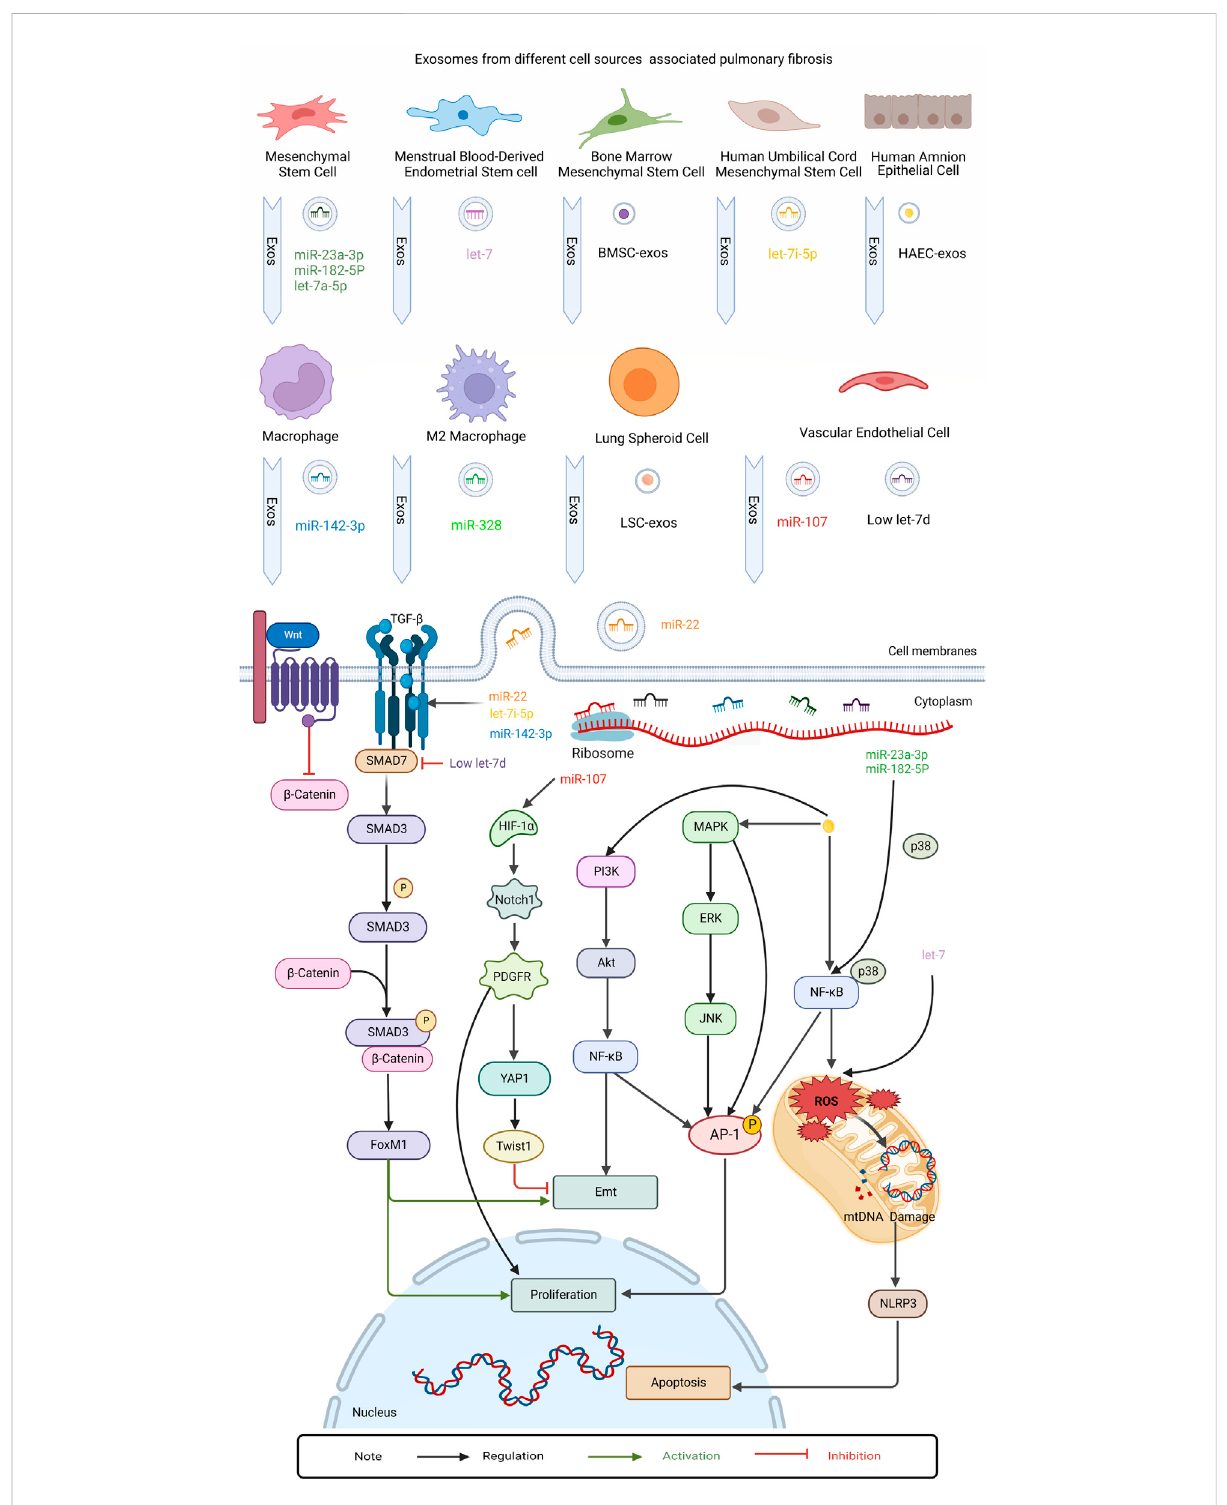
FIGURE 4 This fi gure summarizes the role of regulatory exosomes in PF. Mechanism investigation revealed that exosomes secreted by different kinds of cells, eg: human amnion epithelial cell (HAEC), Menstrual Blood-Derived Endometrial Stem Cell (MenSC), Mesenchymal stem cells (MSC), Human umbilical cord mesenchymal stem cell (HUCMSC), Bone marrow mesenchymal stem cell (BMSC), Pluripotent stem cell (iPSC), Lung spheroid cell(LSC), Vascular endothelial cell (EnC), Macrophage, M2 macrophages. The exosomes transmitted protein cargo and microRNAs regulated MAPK, NF-kb, PI3k/Akt, Wnt/ β -catenin, TGF β RI/FoxM1/Smad/ β -catenin, HIF-1 α /Notch1/PDGFR β /YAP1/ Twist1 signaling pathways. Finally these pathways assess their interaction with epithelial-mesenchymal transition, apoptosis and proliferation in contradicting fi